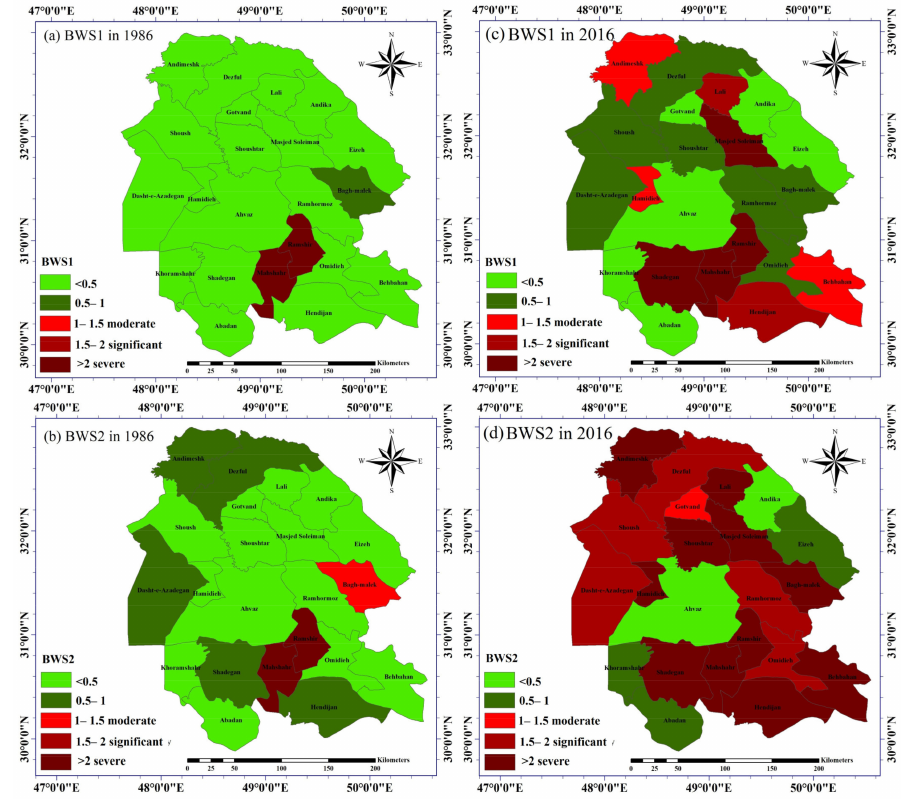
Figure 12. Spatial variation of blue water scarcity indices (BWS1 and BWS2) in the Khuzestan province in 1986 ( a , b ) and 2016 ( c , d